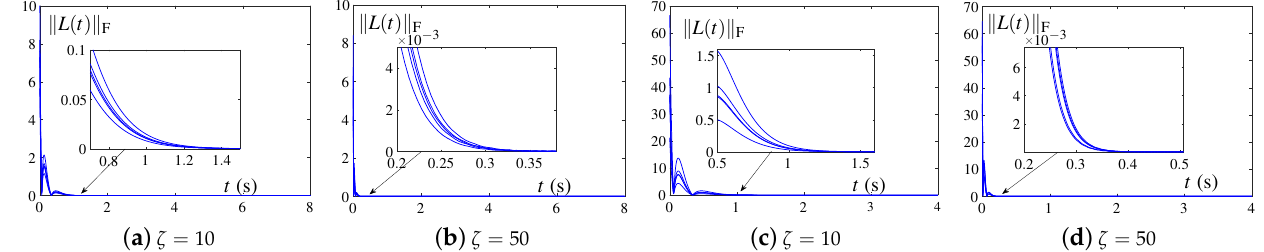
Figure 2. Residual error trajectory of CNRZNN model (7) for solving CTDLE (14) and (15) under the noise-free condition. ( a ) Solving CTDLE (14). ( b ) Solving CTDLE (14). ( c ) Solving CTDLE (15). ( d ) Solving CTDLE (15).